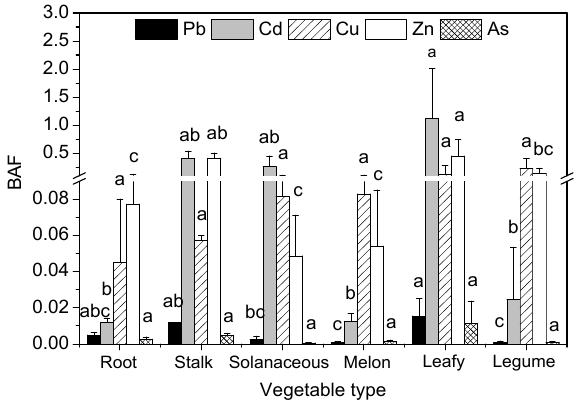
Figure 2. Bioaccumulation factors (BAFs) of heavy metals in six vegetable types. Error bars indicate standard error of three replicates. The different letters indicate significant difference at p < 0.05 (Duncan’s test).